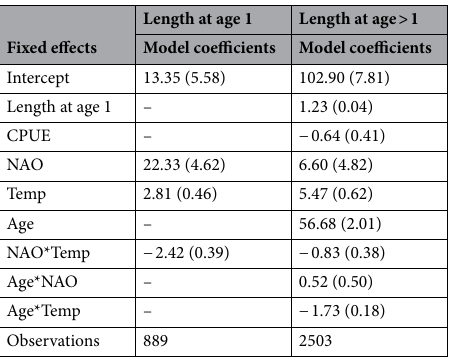
Table 1. Estimated model coefficients for the fixed effects in the most supported model for length at age 1 and length at age > 1, respectively. Numbers in parenthesis represent standard errors for the estimates.